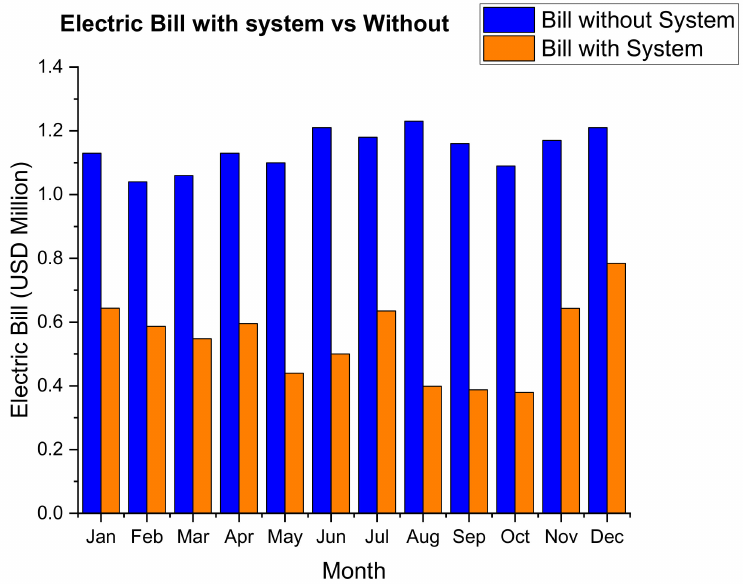
Figure 30. Monthly electric bill with the CSP and TES system vs. without.